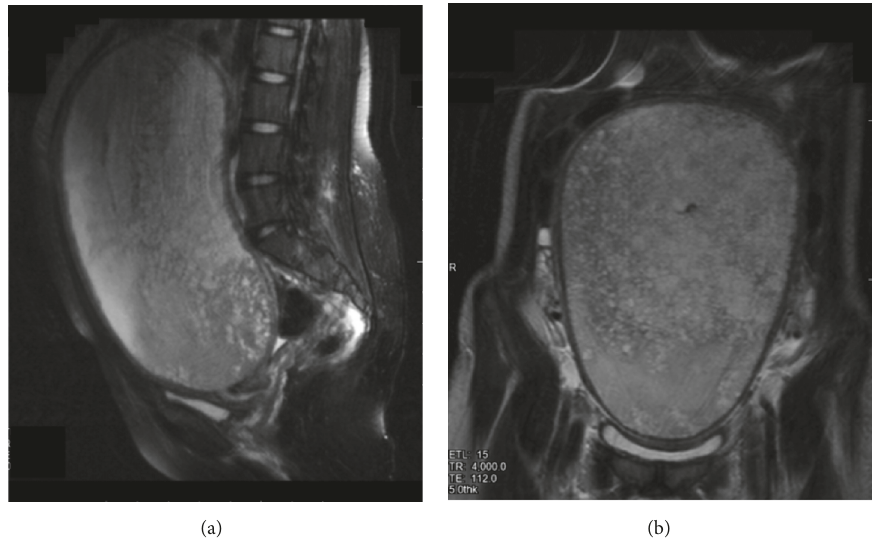
Figure 1: Sagittal (a) and coronal (b) views of an abdominal-pelvic Magnetic Resonance Imaging showing an enlarged uterus (24 × 11 × 17cm) with a large intrauterine heterogeneous mass.